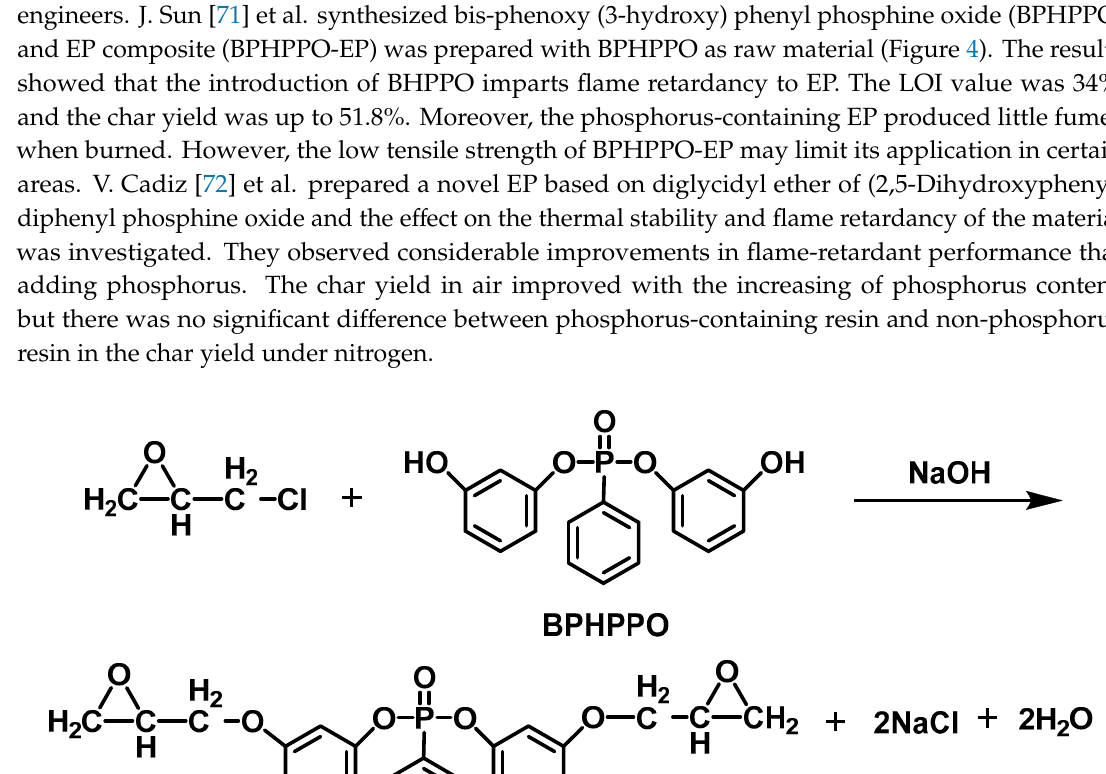
Figure 3. Structures for Al (MEP) and Al (DEP). Readapted with permission from Ref. [70], Copyright 2011, Society of Plastics Engineers.